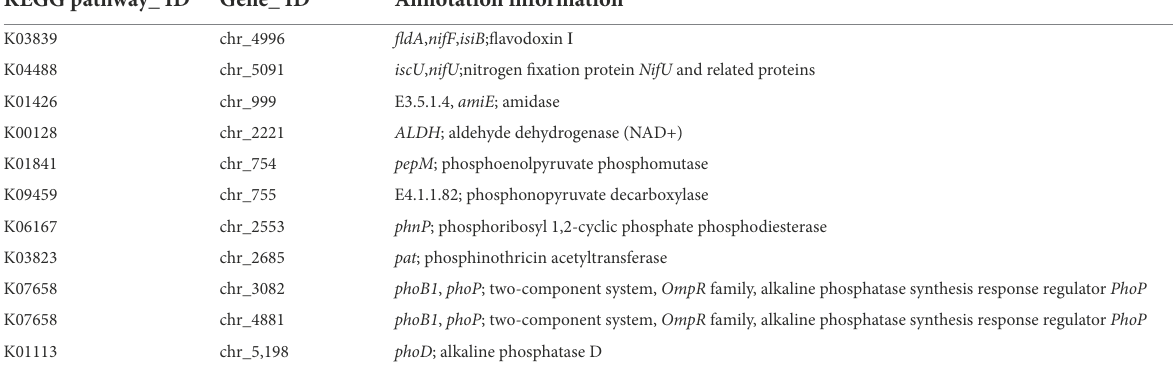
TABLE 3 Genes related to the promotion of plant growth(partial). KEGG pathway_ ID Gene_ ID Annotation